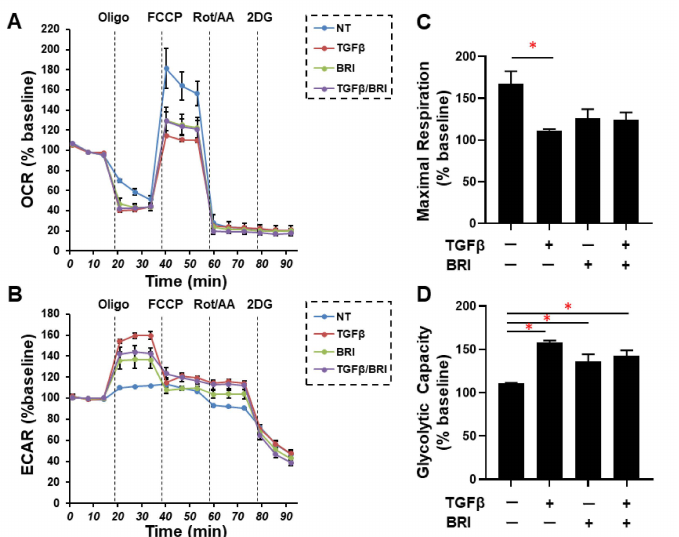
Figure 2. The 2D HTM cells on day 6 untreated (NT) or treated with 5 ng/mL TGF- β 2 (TGF β ) in the presence or absence of 10 µ M brimonidine (BRI) were subjected to a Seahorse XFe96 Bioanalyzer to evaluate the real-time metabolic cellular functions. The oxygen consumption rate (OCR, panel ( A )) and extracellular acidification rate (ECAR, panel ( B )) were simultaneously measured at the baseline, and thereafter, they were further measured by subsequent supplementation with oligomycin (Oligo: complex V inhibitor), FCCP (a protonphore), and rotenone/antimycin A (complex I/III inhibitors) and 2-DG (hexokinase inhibitor). Values are expressed as 100% of the baseline. Maximal respiration ( C ) was defined by OCR with FCCP. Glycolytic capacity ( D ) was defined by ECAR with oligomycin. “+” is reagents addition. “ − ” is reagents non-addition. All experiments were conducted in triplicates using freshly prepared samples ( n = 4). Regarding the data, the mean ± standard error of the mean (SEM) are shown. * p < 0.05; ANOVA followed by a Tukey’s multiple comparison